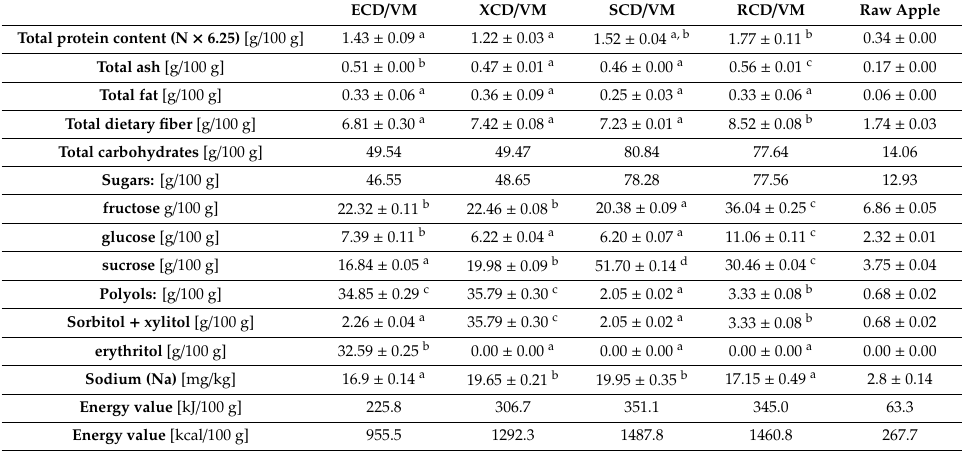
Table 4. Results of chemical analysis of raw apple tissue, and dried by combined method – previously osmo-dehydrated in erythritol (ECD / VM), xylitol (XCD / VM), sucrose (SCD / VM), without OD (RCD / VM). ECD / VM XCD / VM SCD / VM RCD / VM Raw Apple Total protein content (N × 6.25) [g / 100